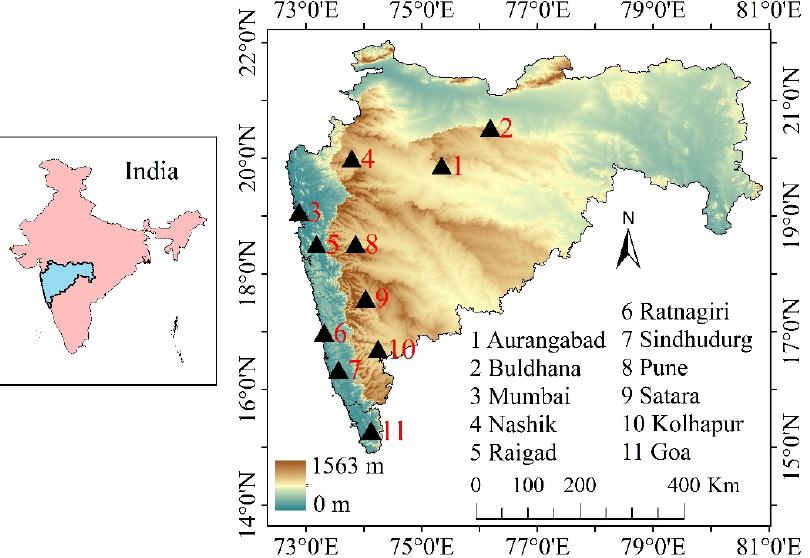
Figure 3. Topography of the WG mountains. Location of cities in six subareas of Maharashtra state was considered in the study. was considered in the